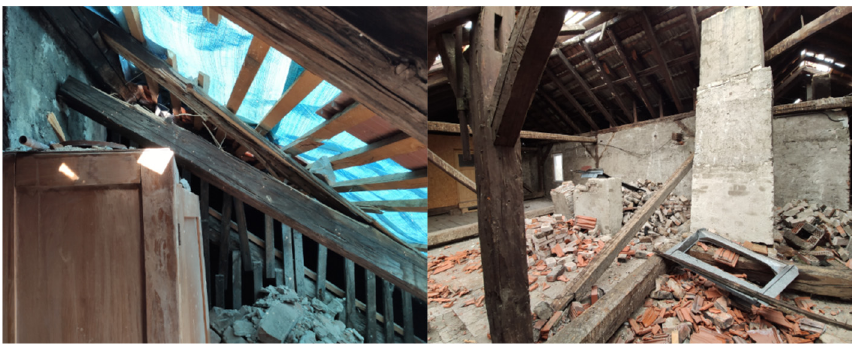
Figure 4. Damages to the roofs and chimneys. (Photo credit: Mislav Stepinac).